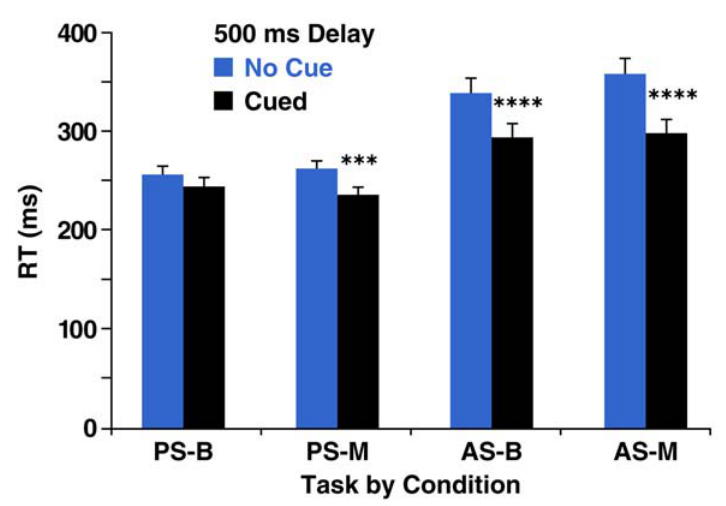
FIGURE 5. Response times, Experiment 2. Mean response times for Experiment 2 (500-ms delay only) for cued vs. no cue trials for prosaccade and antisaccade tasks in mixed and blocked presentations. Cueing effects were significant for all antisaccade trials, but for prosaccade trials only in the mixed presentation. PS, prosaccade task; AS, antisaccade task; B, blocked presentation; M, mixed